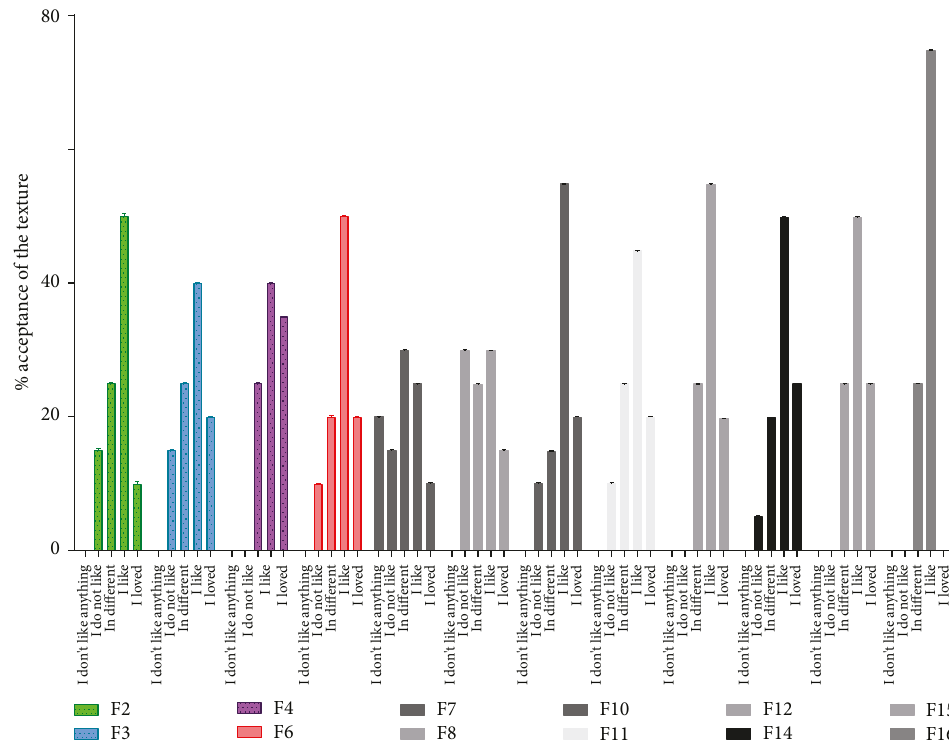
Figure 11: Acceptance percentage of the texture by the panelists for the di ff erent formulations.